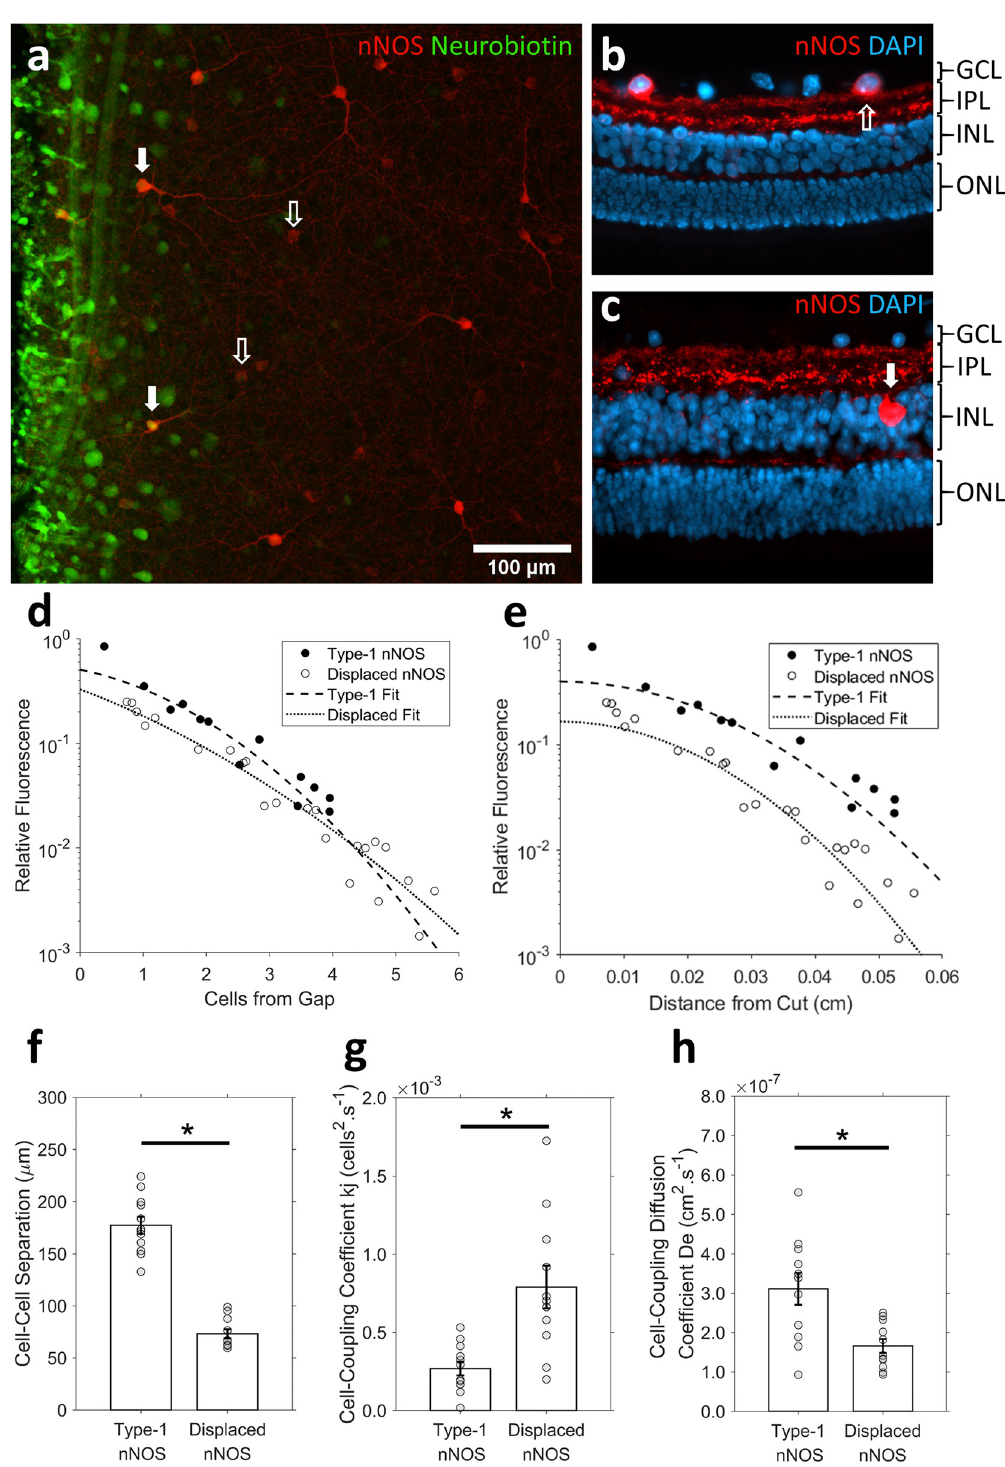
Fig 8. Identification of amacrine cells expressing neuronal nitric oxide synthase loaded with molecular tracer via cut- loading. (a) Image created from z-stack slices spanning from the inner nuclear layer to the ganglion cell layer, flattened using the z-project function in Fiji. Open arrows, type-1 nNOS amacrine cells; solid arrows, displaced nNOS amacrine cells. (b, c) Vertical retinal sections labelled for nNOS (red) and DAPI (blue). (b) Open arrows highlight type-1 nNOS amacrine cells located in the inner nuclear layer (INL), (c) solid white arrows highlight displaced nNOS amacrine cells located in the